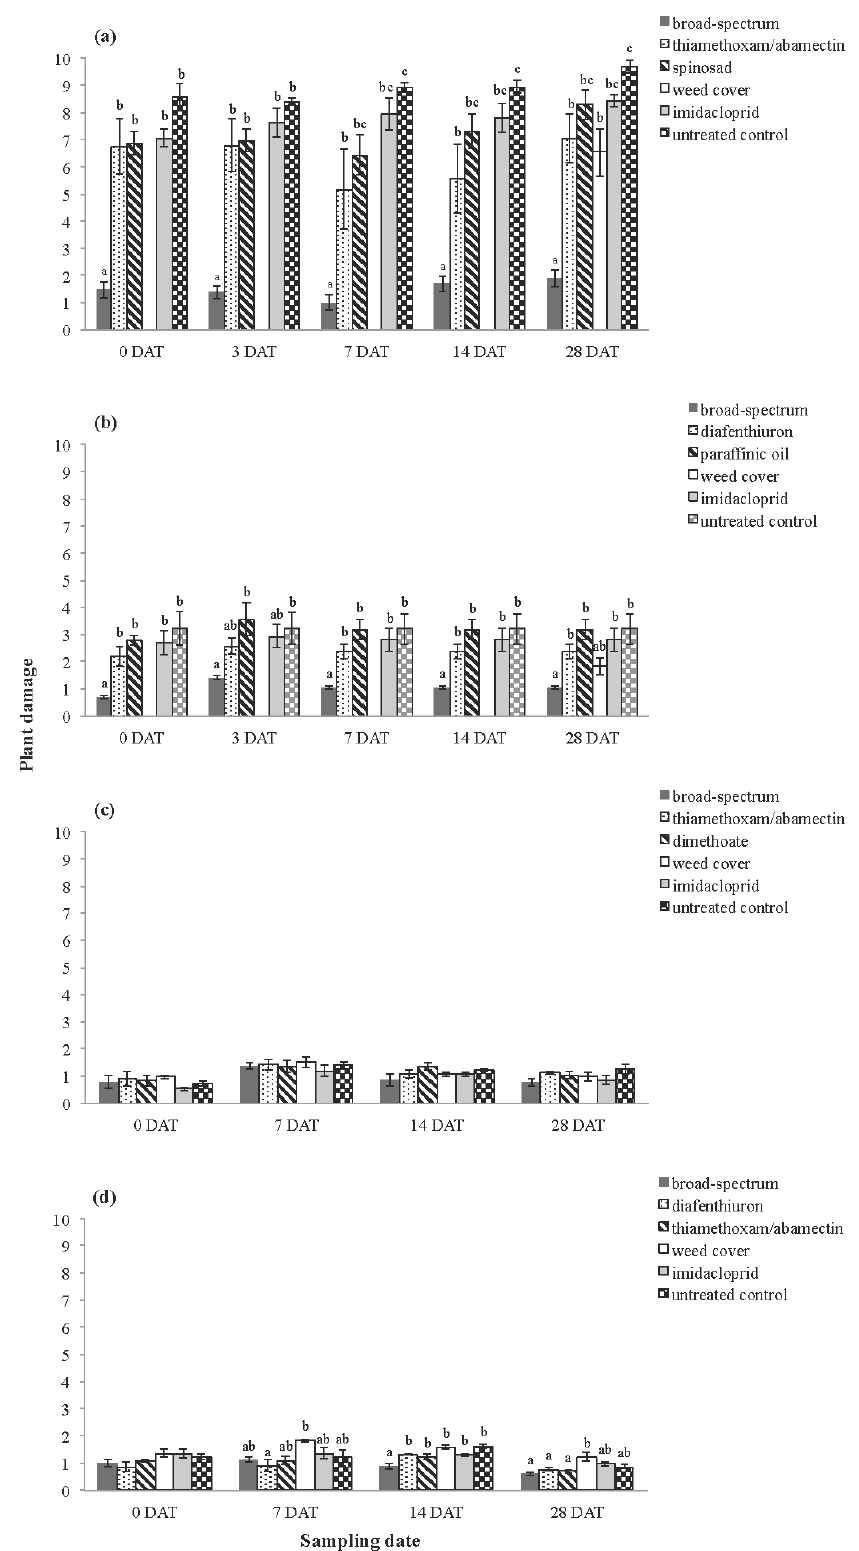
Figure 6. Average plant damage scores at ( a ) Inverleigh 2009, ( b ) Rossbridge 2009, ( c ) Inverleigh 2010 and ( d ) Rossbridge 2010. Plant damage was not scored for the Weed cover treatment at zero, three, seven and 14 DAT at Inverleigh 2009 and Rossbridge 2009. Error bars represent standard error of the mean. Different letters above bars indicate significantly different means at each sampling date (at the p < 0.05 level, Tukey’s- b post hoc